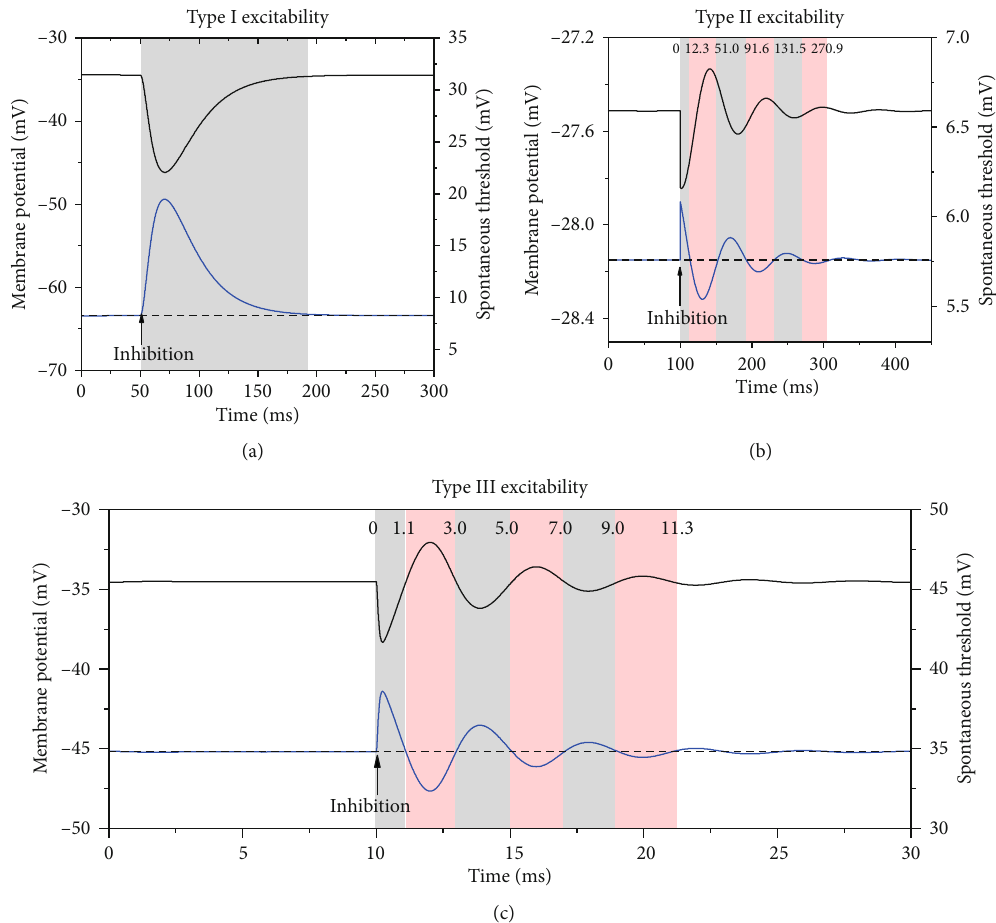
Figure 11: The subthreshold oscillations (black) induced by an inhibitory stimulation and the corresponding “ spontaneous threshold ” (blue). (a) Type I excitability. Inhibition stimulation starts from t = 50 ms. G inh = 1 mS/cm 2 . (b) Type II excitability. The inhibition stimulation starts at t = 100 ms. G inh = 3 : 1 S/cm 2 and τ inh = 0 : 05 ms. (c) Type III excitability. The inhibition stimulation starts at t = 10 ms. G inh = 1 : 1 mS/cm 2 and τ inh = 0 : 05 ms. The pink windows correspond to the lower spontaneous threshold and represent the PIF